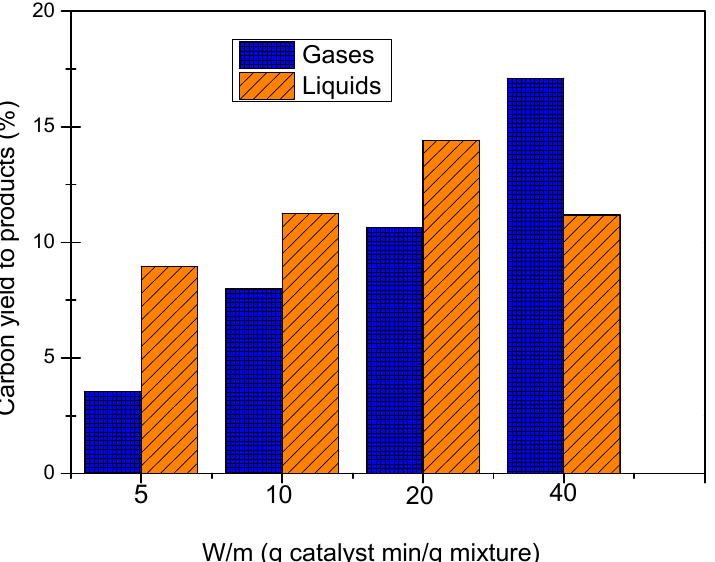
Figure 4. Carbon yield to gases and liquids in the APR of a simulated aqueous fraction of bio-oil at different catalyst loading (T = 227 °C, 40 bar, 5 wt% acetol, 5 wt% butanol and 5 wt% acetic acid, Ni-Co/Al-Mg catalyst, 1 mL/min aqueous feeding rate).